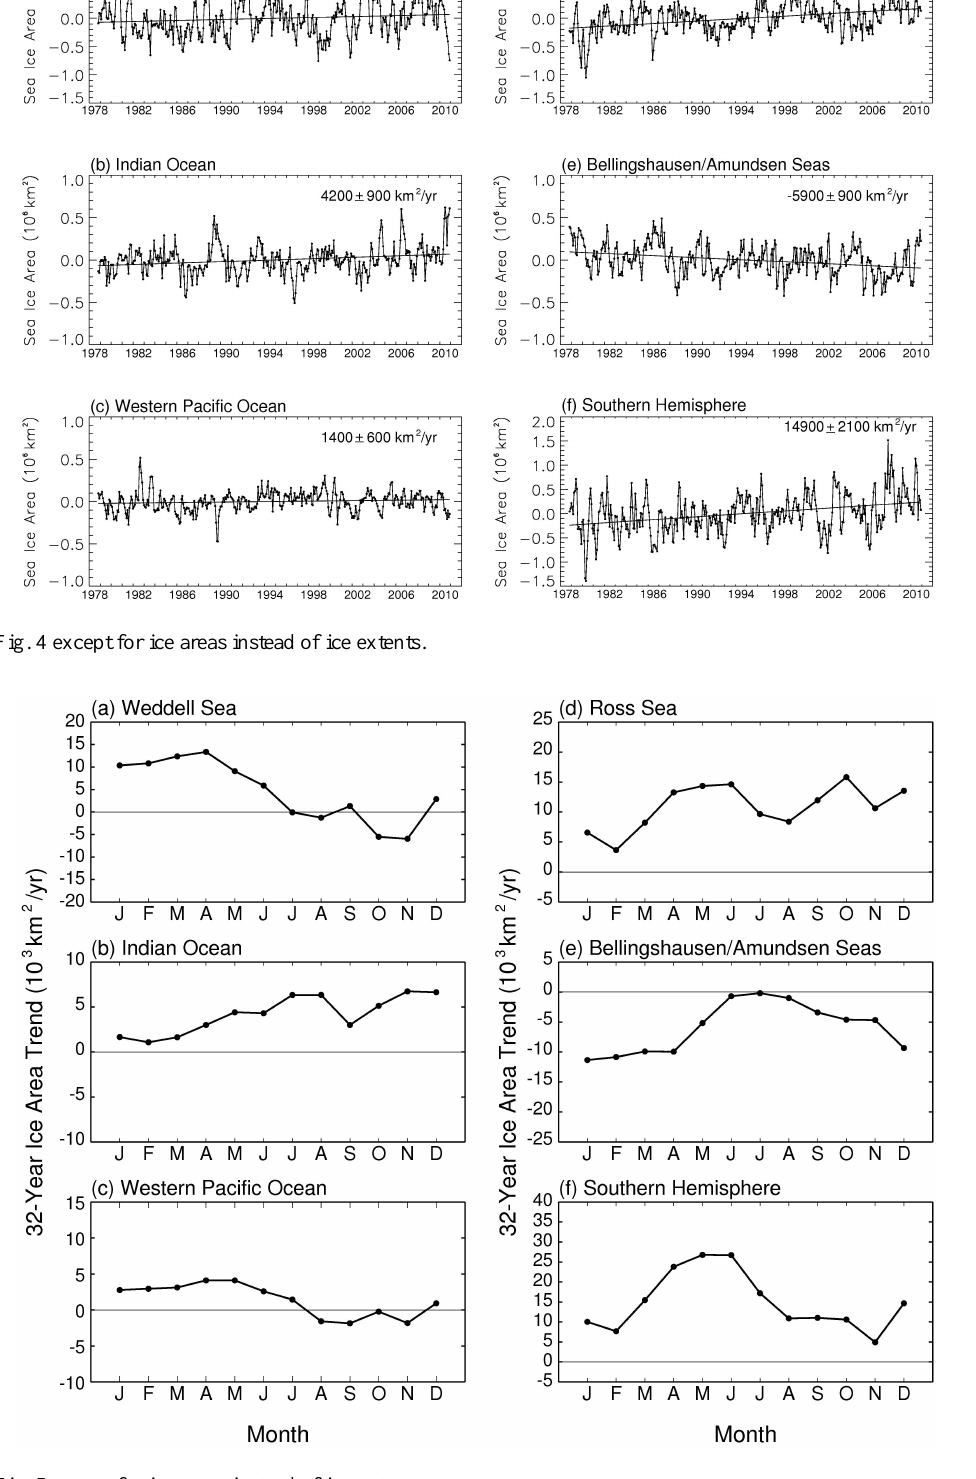
Fig. 8. Same as Fig. 5 except for ice areas instead of ice